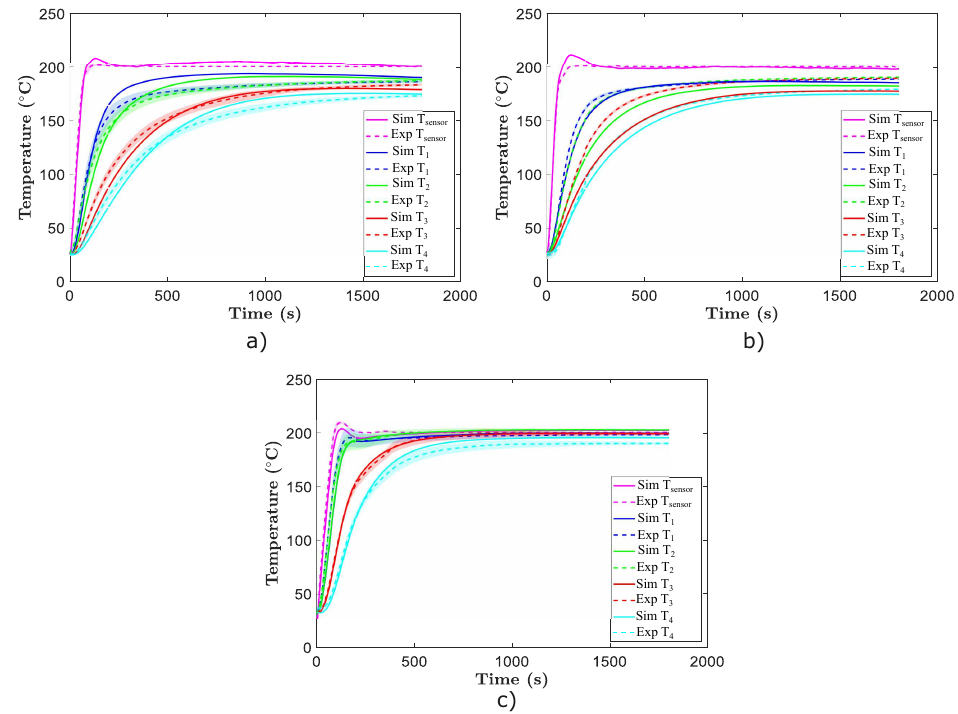
Figure 7. Temperatures of the surface and under the glass (see Figure 1b for location of the tempera- ture sensors) from 0 to 1800 s for both experimental tests (dotted lines) and computational simulations (continuous lines) in Model II: ( a ) WMF pan, ( b ) Schulte pan and ( c ) steel